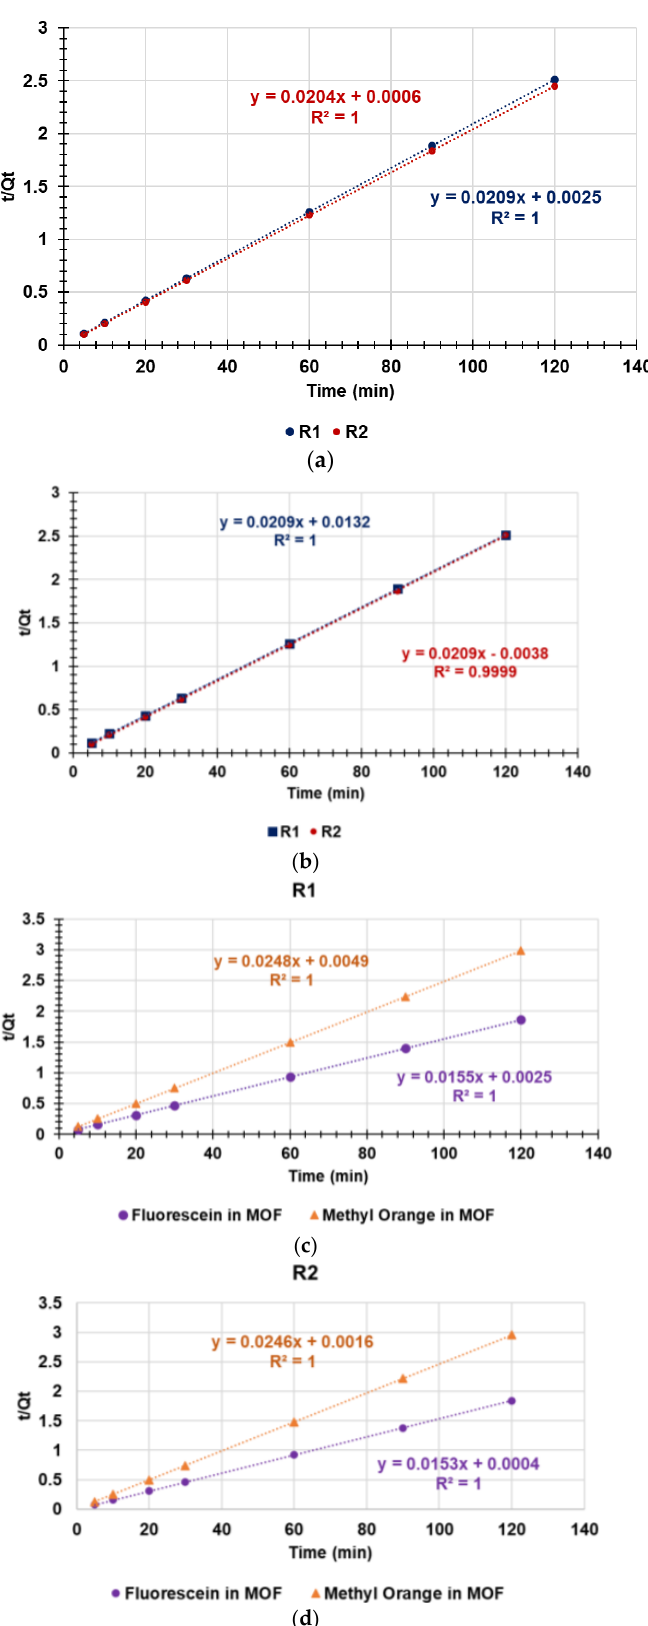
Figure 13. Pseudo-second order kinetic models of F removal using R1 and R2 ( a ), of MO removal using R1 and R2 ( b ), of the removal of F + MO in mixture (MOF) using R1 ( c ) and R2 ( d ). In the processes governed by the PSO kinetics, the velocity limiting step is considered chemical adsorption, including adsorption through the sharing or exchange of electrons between the adsorbent and the adsorbed [60] or electrostatic interactions, which were confirmed to be the main mechanism by which both R1 and R2 absorbed anionic dyes. The values of Qe (cal) and K2 were computed using the values of the slopes and intercepts of the equations in Figure 13 for all experiments and included in Table 6.